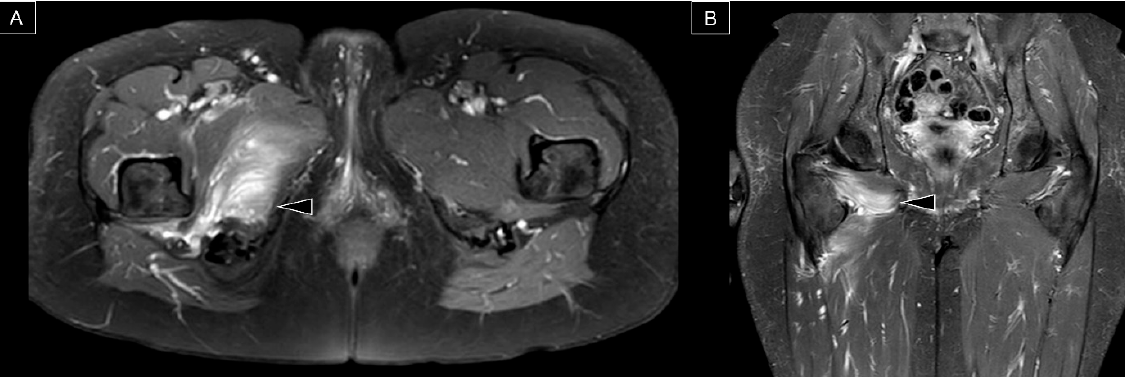
Figure 9. ( A ) Axial and ( B ) coronal views of T2 weighted MRI in another case with post-traumatic IIS, with edema and hematoma inside the quadratus femoris and obturator externus muscles (ar- rowheads).